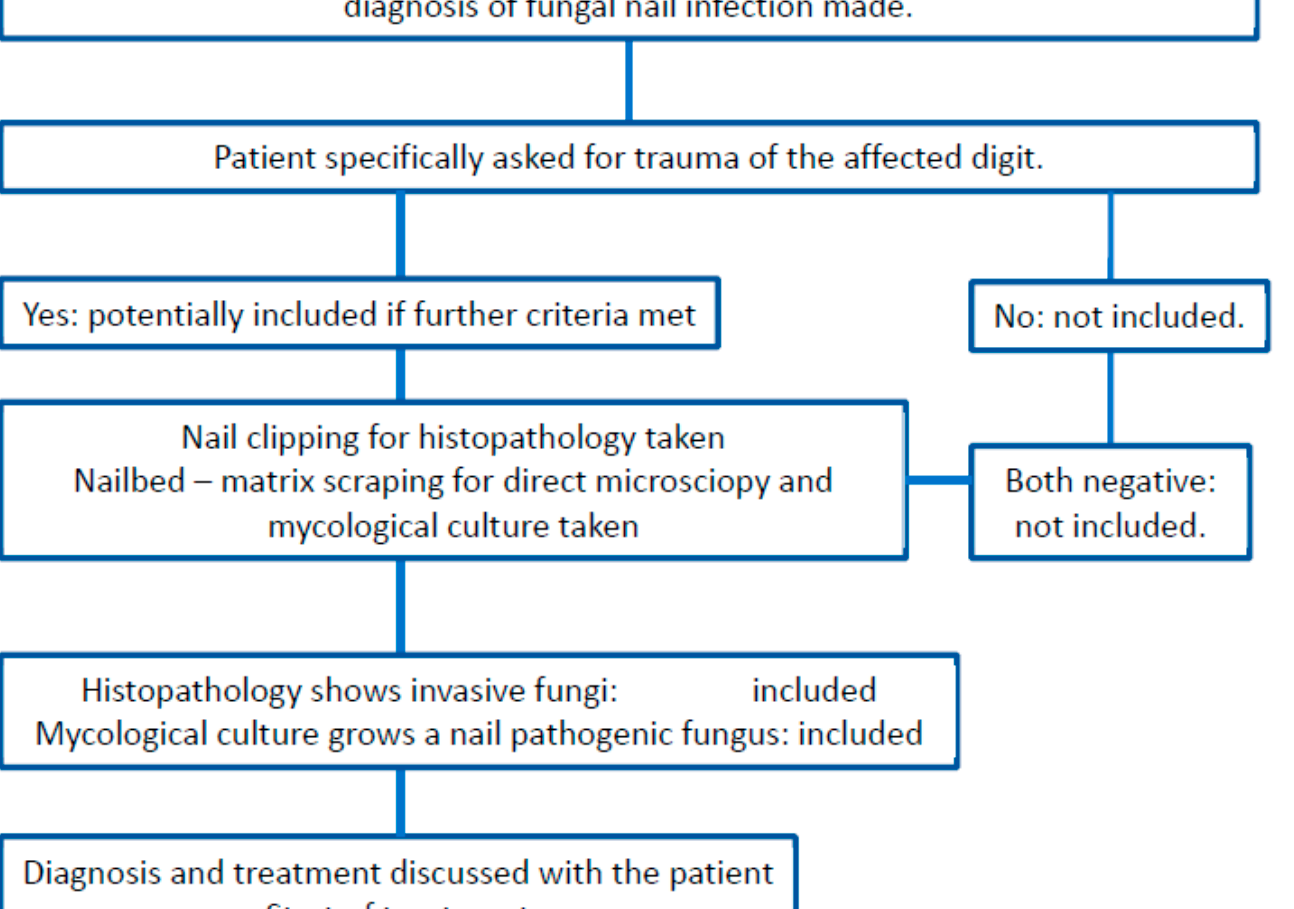
Figure 1. Flow chart of the patient inclusion process. Table 1. Demographic data.